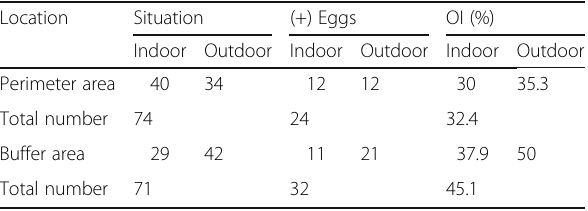
Table 1 Distribution of ovitrap installation in Adisucipto Airport of Yogyakarta